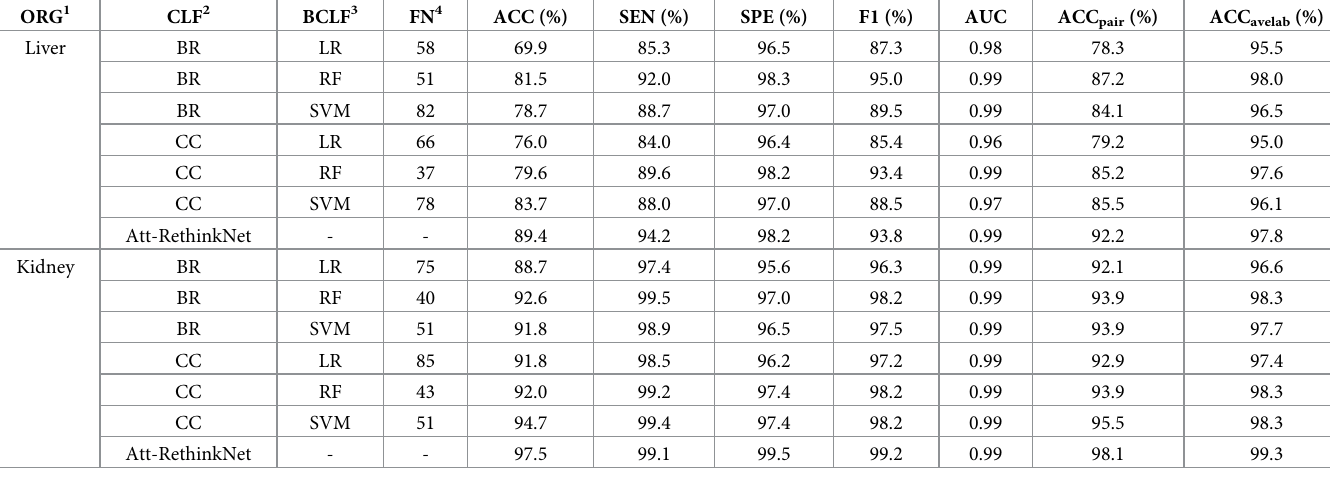
Table 7. The performance of BR, CC and Att-RethinkNet on liver and kidney